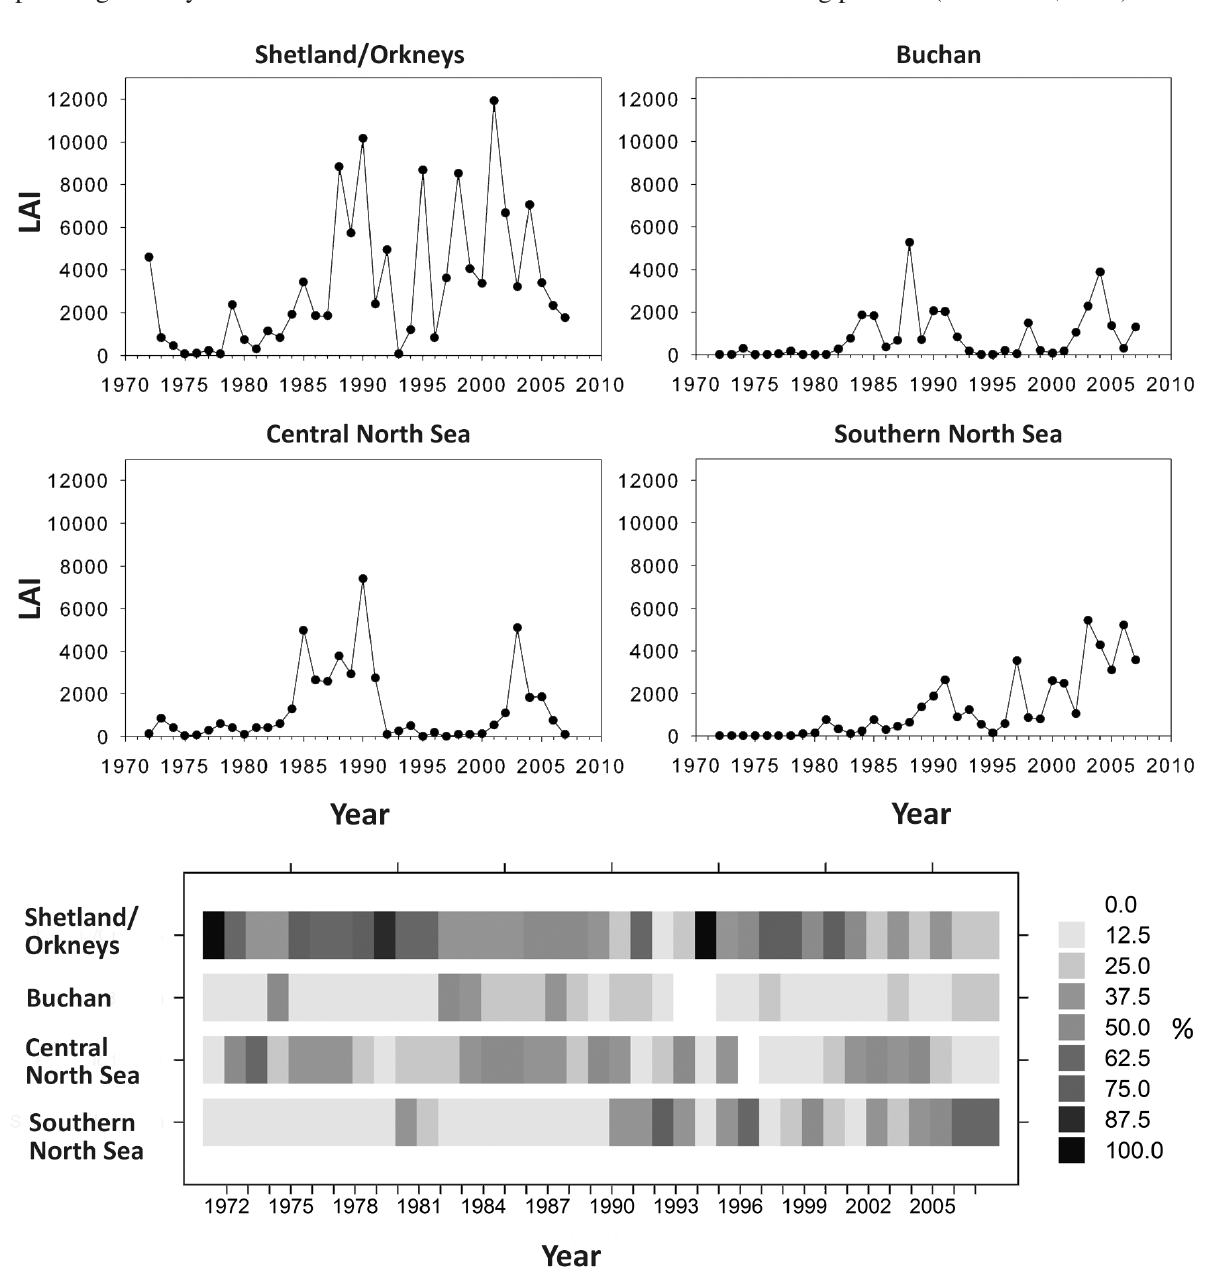
F IG . 2. – Top four panels: time series of larval abundance index (LAI) for the four herring spawning areas in the North Sea. Lower panel: rela- tive importance of individual spawning areas, shown by the proportion; each subarea contributes to the total area in the abundance of newly hatched larvae for a given